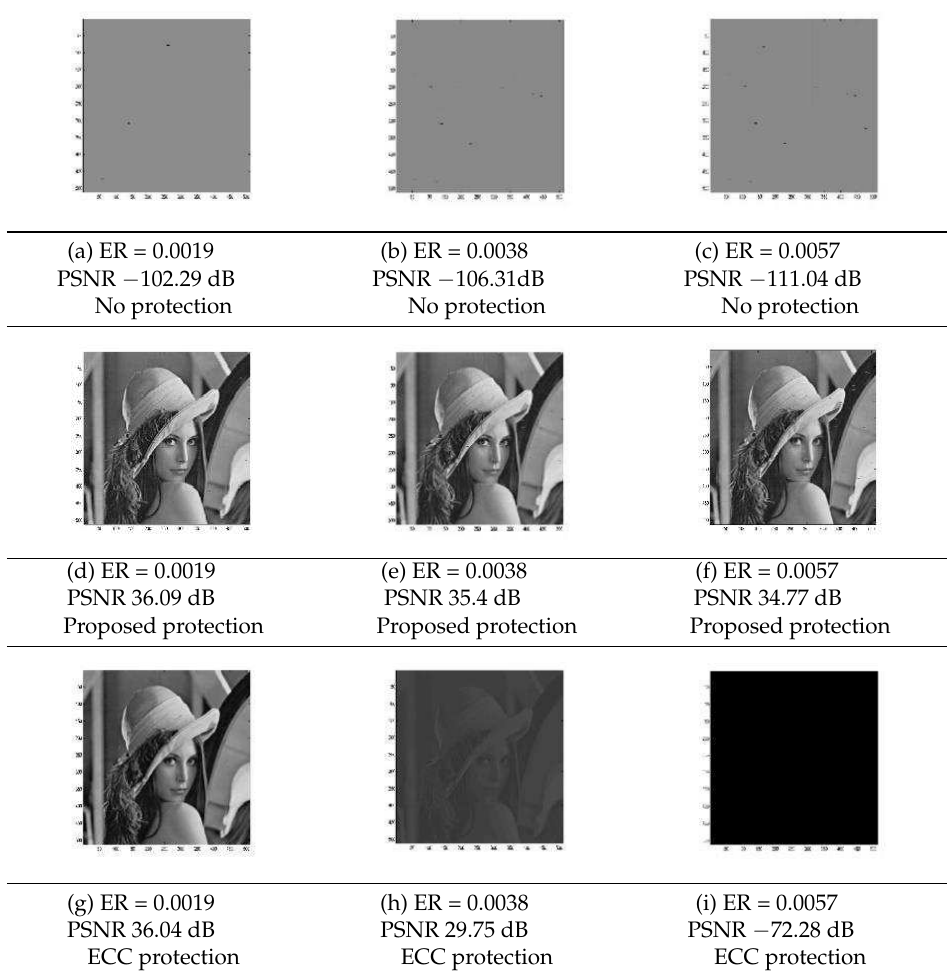
Table 2. Output images under different error injection rate and protection